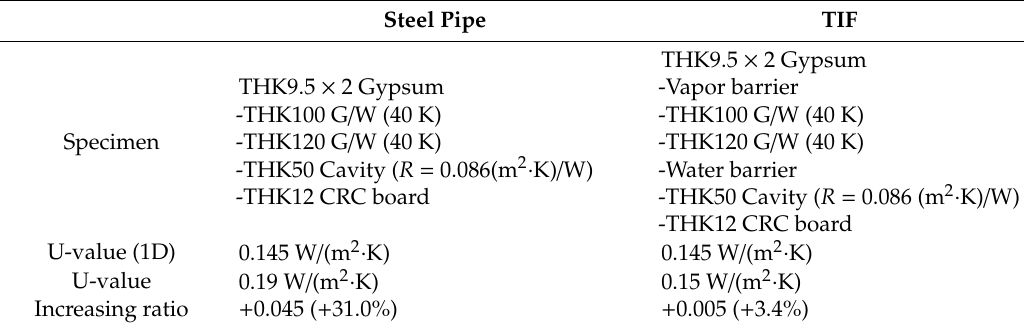
Table 3. Test results of U-value.